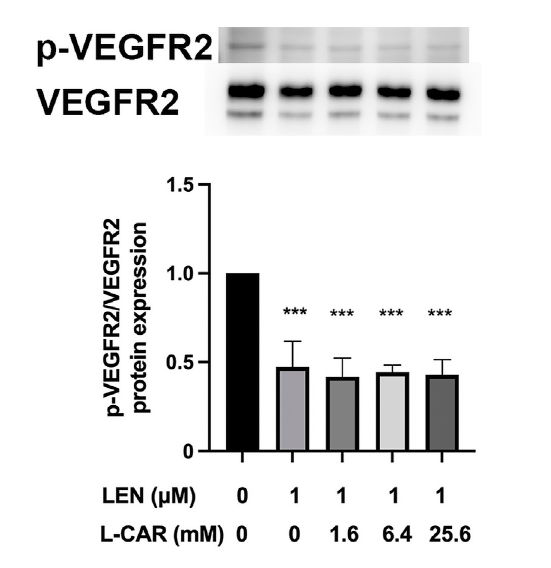
FIGURE 7 Effect of L-carnitine on phosphorylation of vascular endothelial growth factor receptor (VEGFR) 2 in lenvatinib-treated human umbilical vein endothelial cells (HUVECs). The cells were treated with lenvatinib (1 µM), L-carnitine (1.6, 6.4, or 25.6 mM), or vehicle for 24 h. The upper panel represents the results, and the lower panel presents data as the mean +SD of three independent experiments. *** p < 0.001 vs . Ctrl